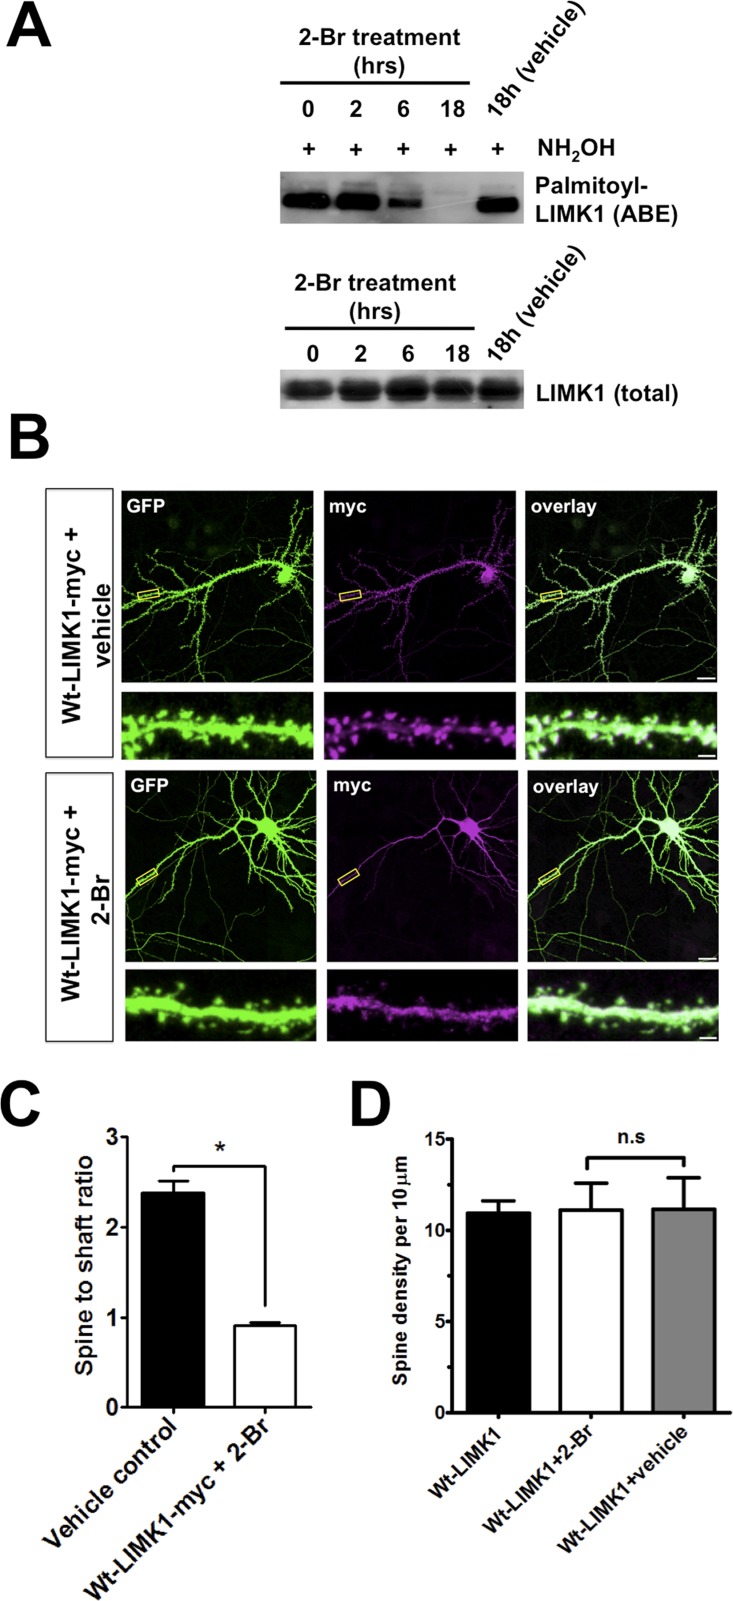
Further evidence that palmitoylation targets LIMK1 to spines.(A) Treatment of hippocampal neurons with the palmitoylation inhibitor 2-Bromopalmitate (2-Br) confirms palmitoylation of LIMK1. Cultured hippocampal neurons (DIV20) were treated with 2-Br (100 µM) or vehicle control (EtOH) for the indicated times. ABE assays were performed to detect palmitoylated and total LIMK1 levels. (B) Representative images of DIV18 hippocampal neurons, transfected to express GFP plus wt-LIMK1-myc, treated with 100 mM 2-Br or vehicle 2 hr post-transfection, fixed 12 hr later and immunostained with the indicated antibodies. Scale bar: 20 μm. Lower panels show magnified images of single dendrites (scale bar: 1 μm). (C) Spine targeting ratio (mean ± SEM) for n = 32 neurons per condition from B. * p < 0.05, ANOVA with Dunnett's post hoc correction. (D) Quantified assessment of dendritic morphology for each condition in B confirms that 2-Br treatment does not affect dendritic spine density, n = 20–30 neurons per condition, p > 0.05, ANOVA with Dunnett's post hoc correction.